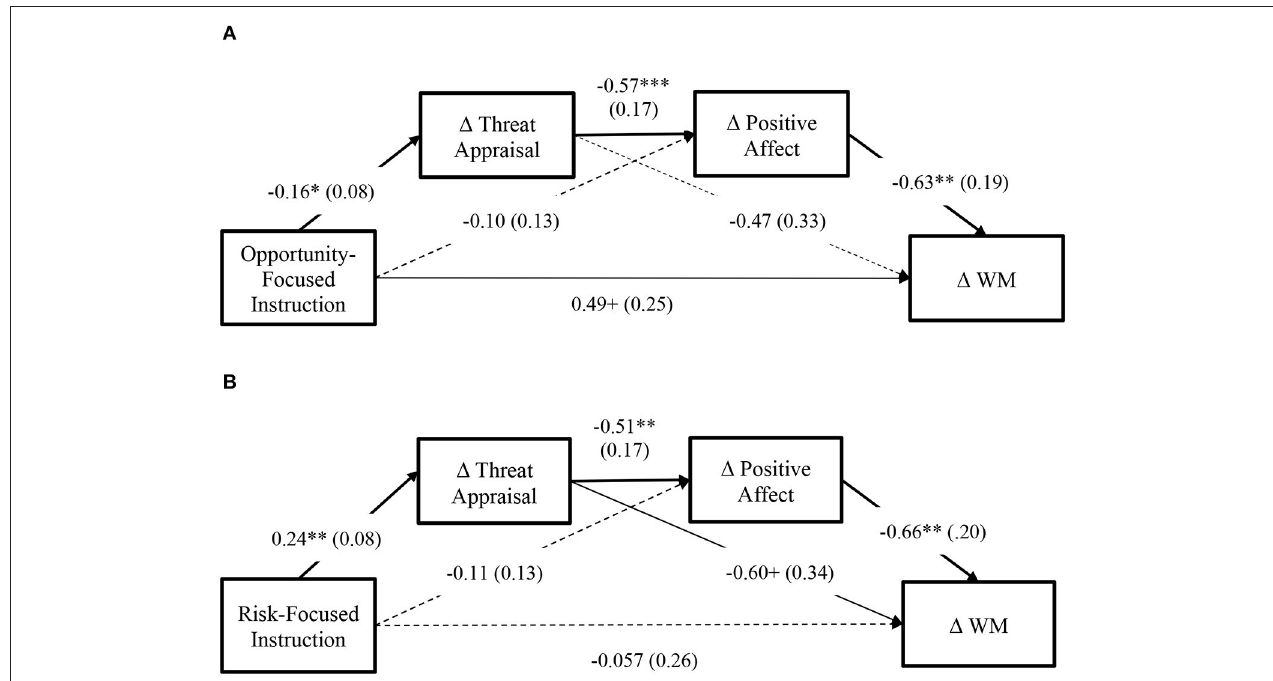
FIGURE 5 | Mediation models. (A) Model of opportunity. (B) Model of risk. Coefficients and standard errors (in parentheses) are presented. Bold lines indicate statistically significant relationship. The normal solid line indicates a marginally significant path. Dashed lines indicate non-significant paths. Gender was dummy coded as 1 = girl, 0 = boy. ** p < 0.01; * p < 0.05; + p <